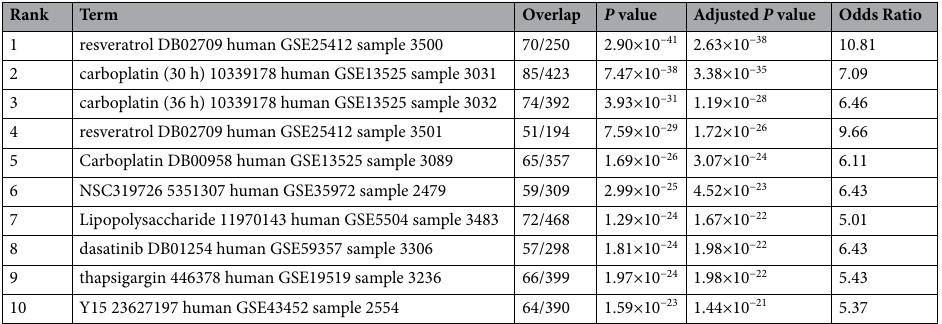
Table 7. Drug perturbations from GEO up for A549 by